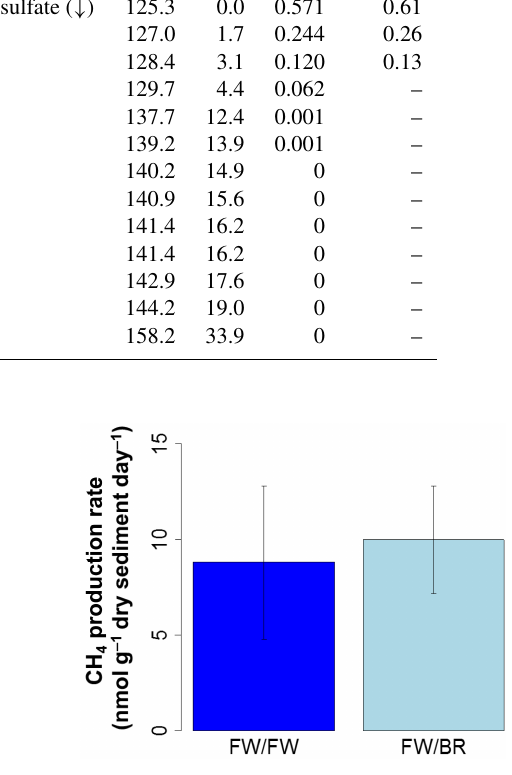
Figure 4. Mean CH 4 production rates (nmolg − 1 dry sedi- mentday − 1 ) from non-tidal freshwater wetland sediments incu- bated with freshwater (FW/FW; n = 5) and other sediments from the same freshwater wetlands incubated with brackish water from tidal brackish wetlands (FW/BR; n = 5). Error bars represent stan- dard errors. This seawater addition experiment was conducted over a 14-day period in June